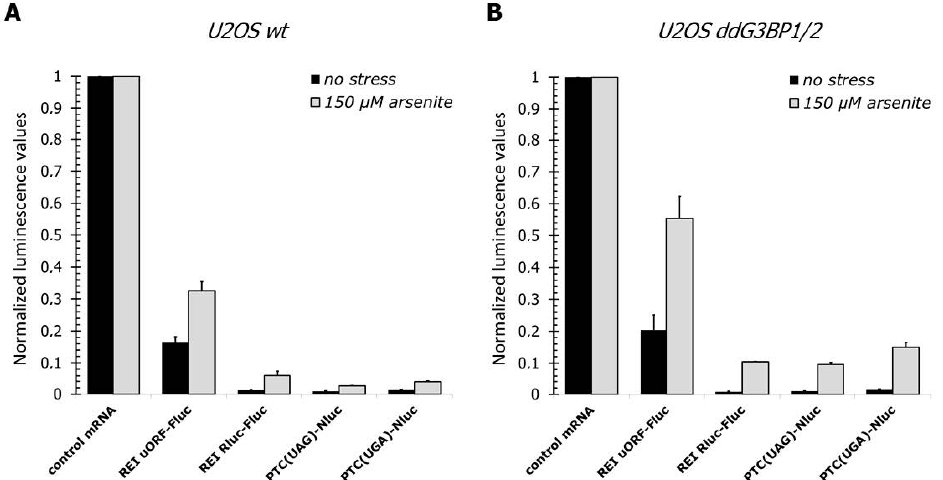
Figure 4. Changes of translation reinitiation and termination in arsenite-treated wt and ddG3BP1/2 U2OS cells. Wt ( A ) and ddG3BP1/2 ( B ) U2OS cells were transfected with the same reporter mRNAs as in Figure 1. Two hours after transfection, cells were lysed, and luciferase activities were measured and normalized, as described above. Translation efficiencies of the reporter mRNAs were normalized by dividing by the translation efficiencies of the corresponding control transcripts, in untreated or 150 µ M arsenite-treated cells. The mean values ( ± SD) of at least three independent experiments are shown. The absolute values were roughly similar to those indicated in the legend in Figure 1 (and were at least two orders of magnitude above the background).